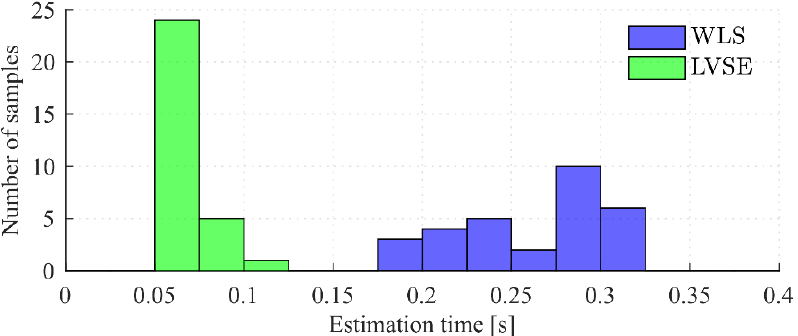
Figure 5. Estimation duration distributions — case 2.